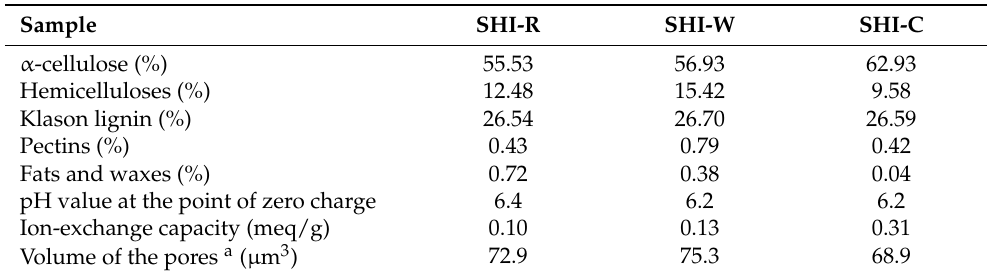
Table 1. Characteristics of the hemp shives samples: SHI-R: raw shives; SHI-W: water-washed